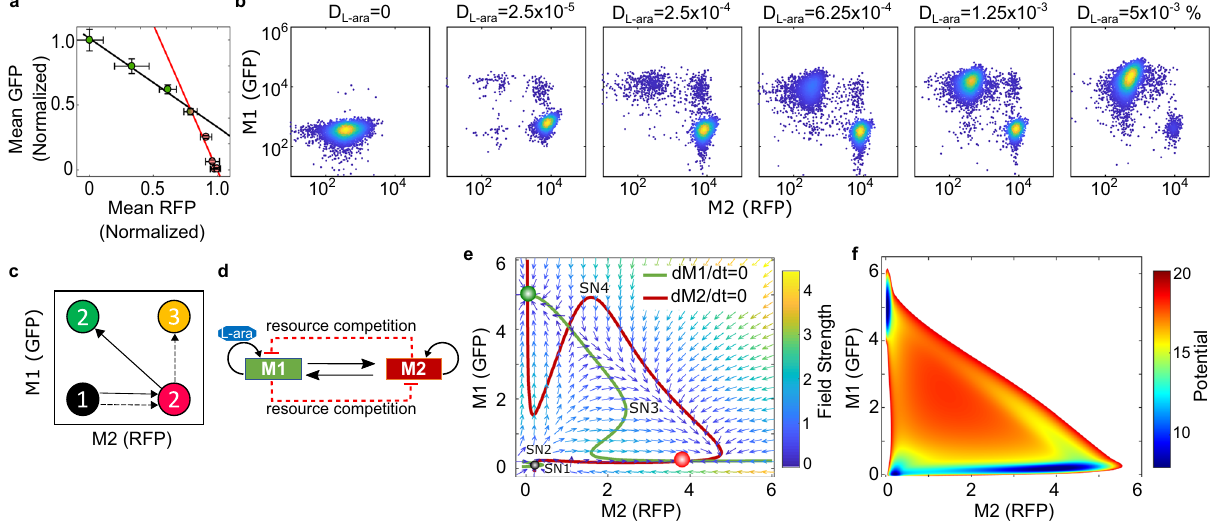
Fig. 2 Resource competition deviates the cell fate transitions in the one-strain Syn-CBS circuit. a The normalized steady-state signal intensity of average RFP vs. GFP measured by a plate reader shows a two-phase piecewise linear relationship. Data displayed as mean ± SD ( n = 3 biological independent samples). b Flow cytometry data show cell state transitions in one-strain Syn-CBS circuit with increasing level of inducer L-ara ( D L-ara ). In total, 10,000 events were recorded for each sample. Data shown from one representative of four independent biological replicates. c Diagram of the perturbed state transitions by resource competition. Dash line: expected path. Solid line: perturbed path. d Diagram of the revised model by including resource competition. e Phase plane diagrams. The nullclines of M1 and M2 are shown in green and red, respectively. The vector fi eld of the system is represented by small arrows, where the color is proportional to the fi eld strength. The three cell fates are indicated by fi lled circles (black, red, and green) at the intersections of the two nullclines. f Calculated potential landscape. Circuit CT61 was used here. Source data are provided as a Source Data fi piecewise linear function, showing a shallow slope when the GFP level was high (black curve, Fig. 2a) and a steep slope when the RFP level was high (red curve, Fig. 2a). To further study this phenomenon, we measured cell fate transitions at the single-cell level with fl ow cytometry under various concentrations of L-ara.